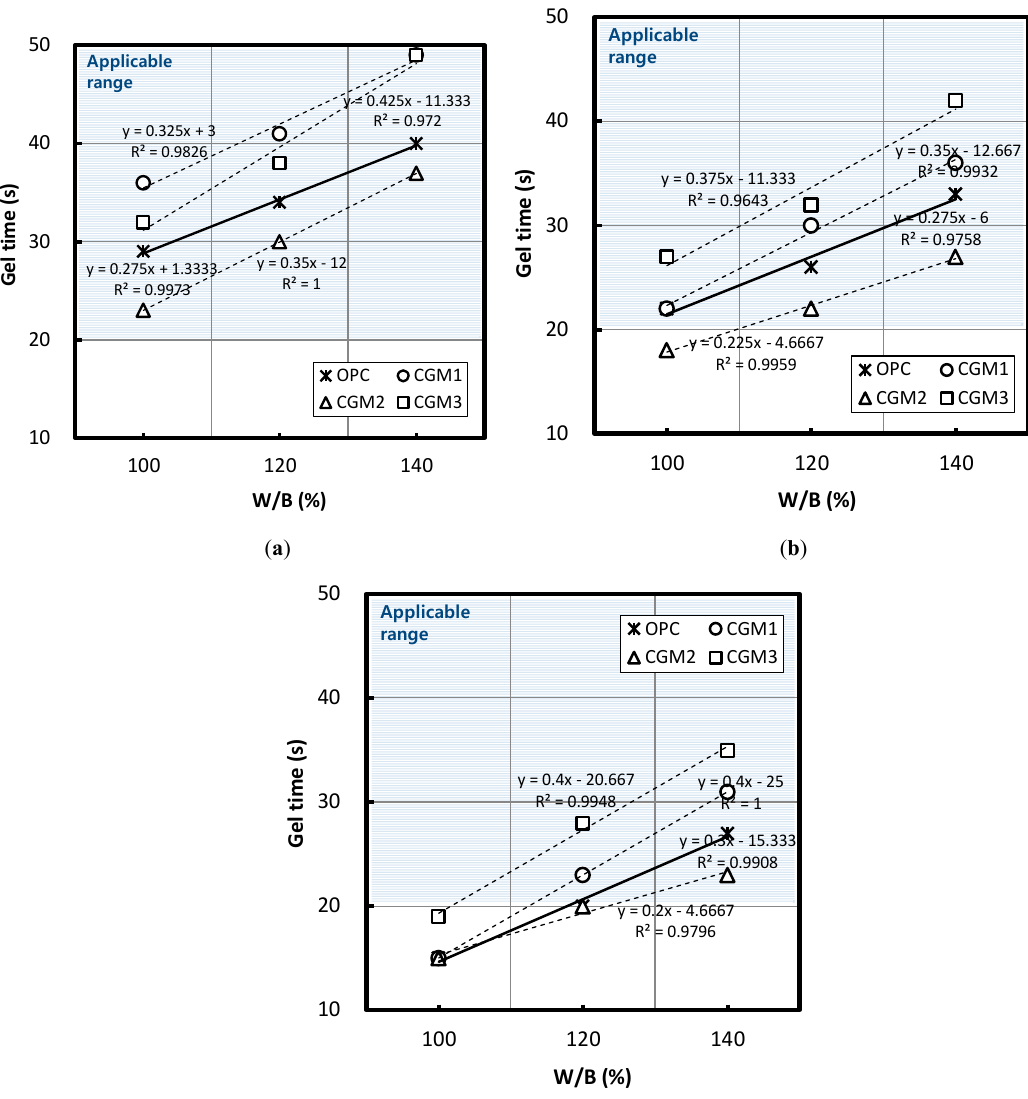
Figure 4. Gel time based on water / binder (W / B) ratio of Liquid B for Liquid B / CLGM equal to ( a ) 50%, ( b ) 60%, and ( c ) 70%.